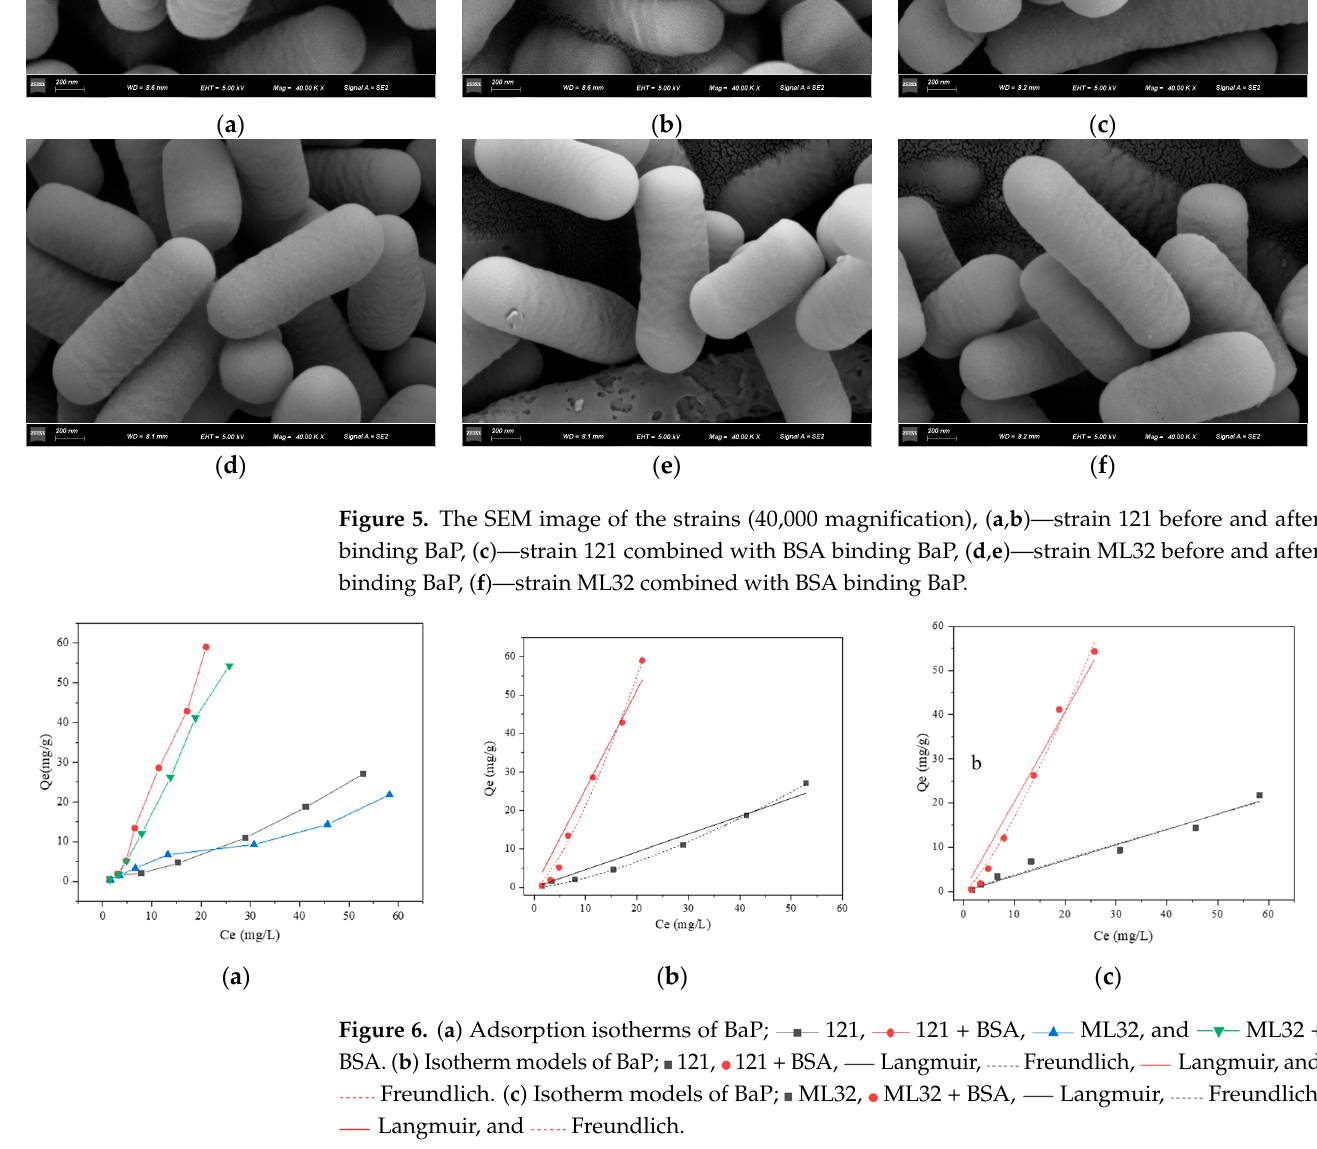
Langmuir Model Freundlich Model